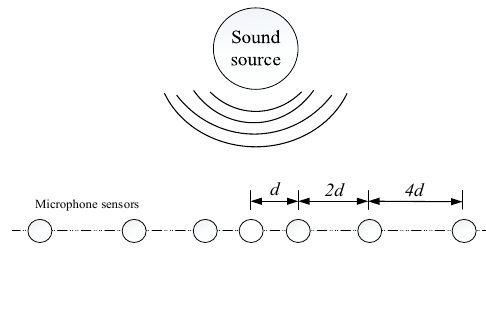
Figure 1. Non-uniform linear microphone array